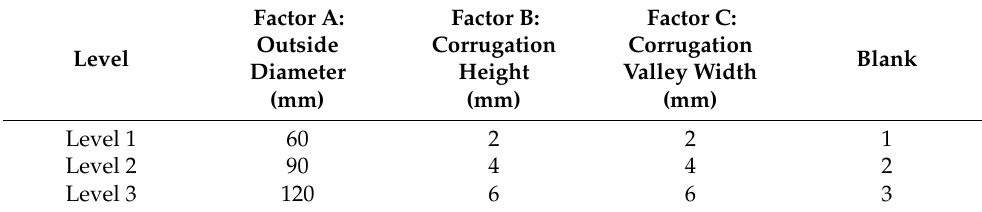
Table 3. Factors and